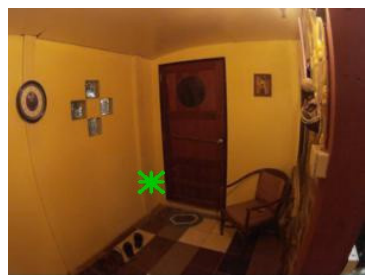
Figure 7. “Empty triangle”.